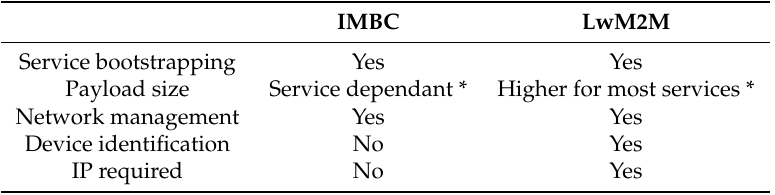
Table 1. Similarities and differences between IMBC and LwM2M.